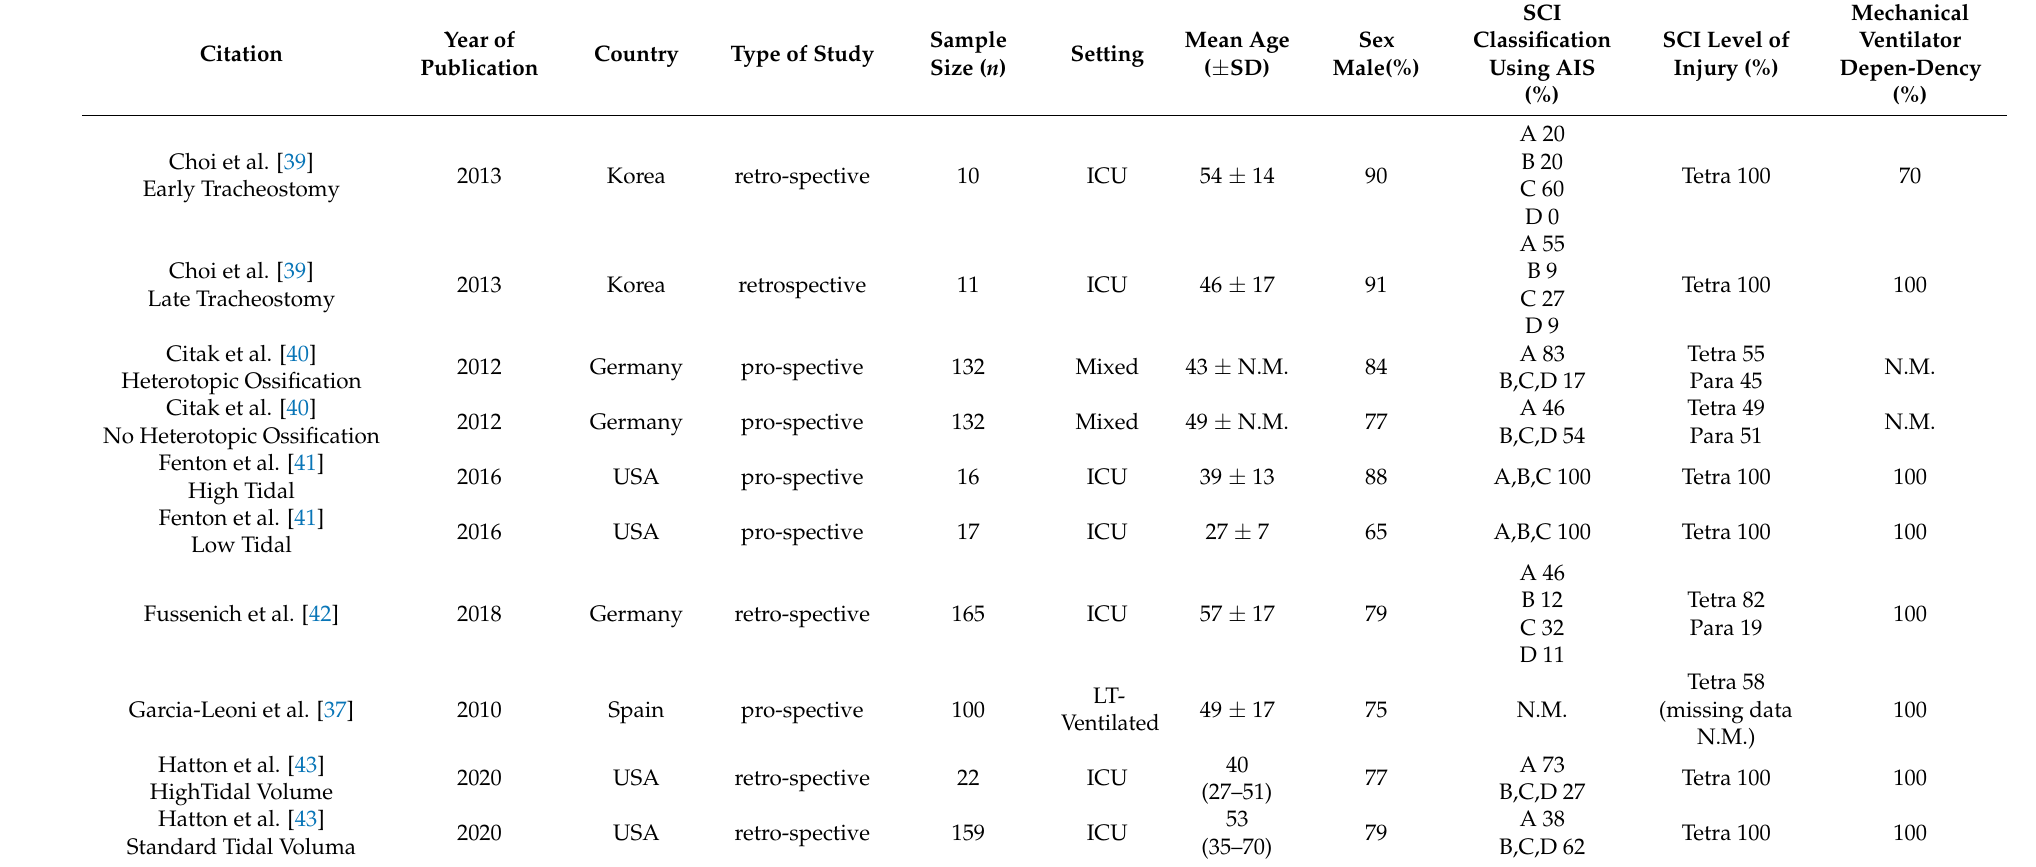
Table 1. Characteristics of 24 included studies with 34